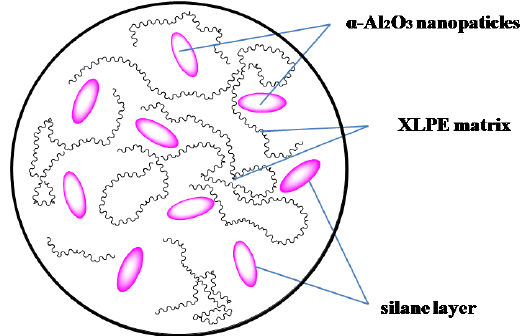
Figure 1. Schematic diagram of dispersion of nanoparticles in matrix.